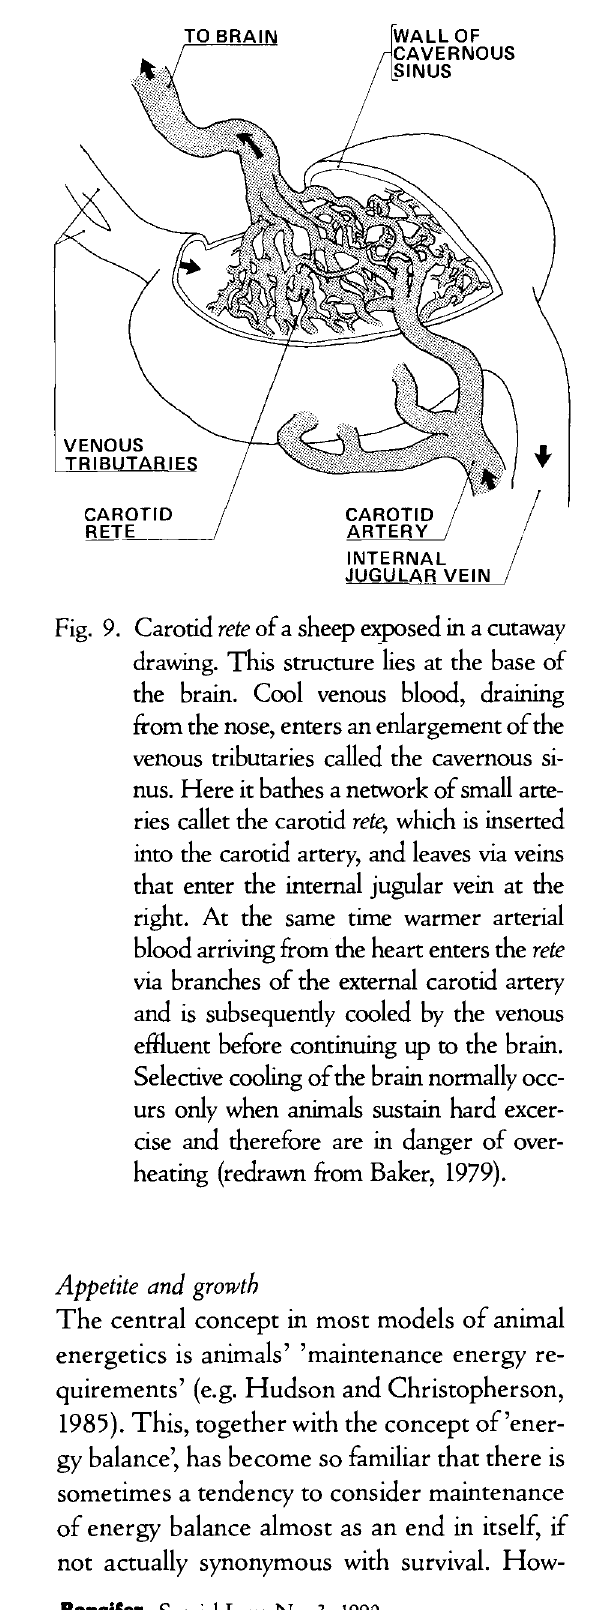
cise and therefore are in danger of over heating (redrawn from Baker,